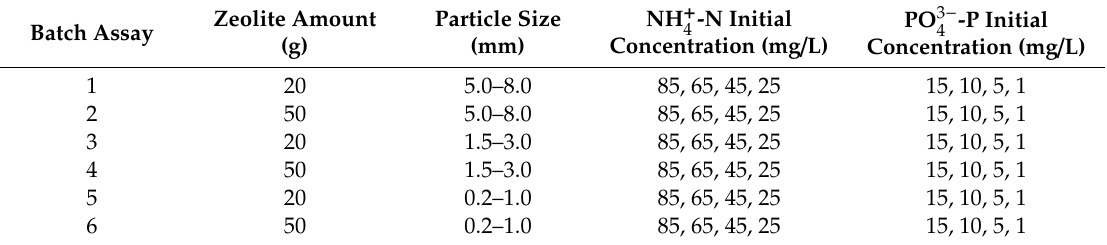
Table 2. Experimental design used in NH + adsorption